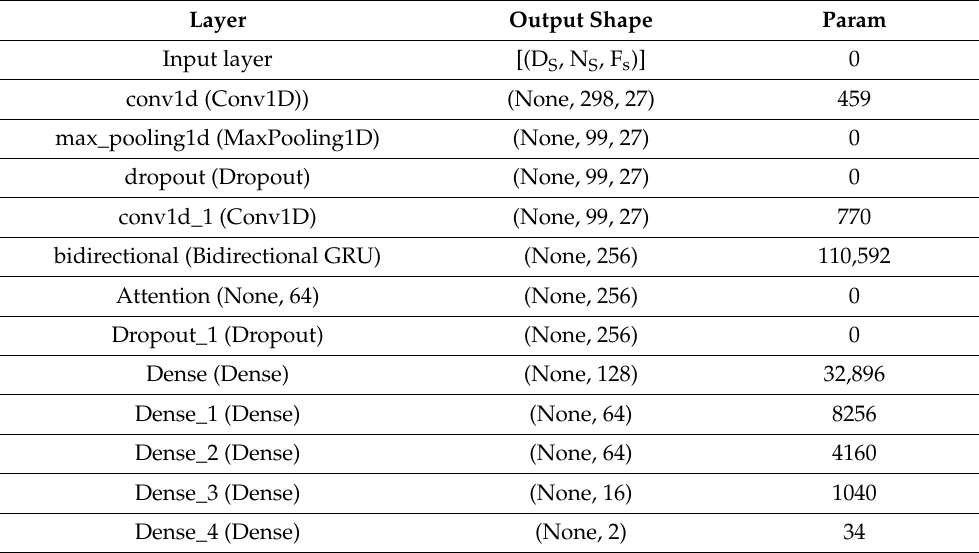
Table 2. Detailed information on input shape and number of parameters in proposed Enhancer- AttGRU